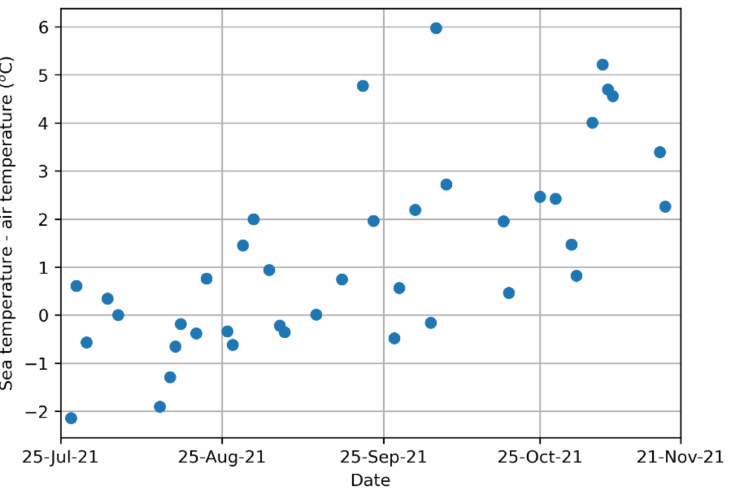
Figure 11. Time series of sea-surface water–air temperature differences in the study